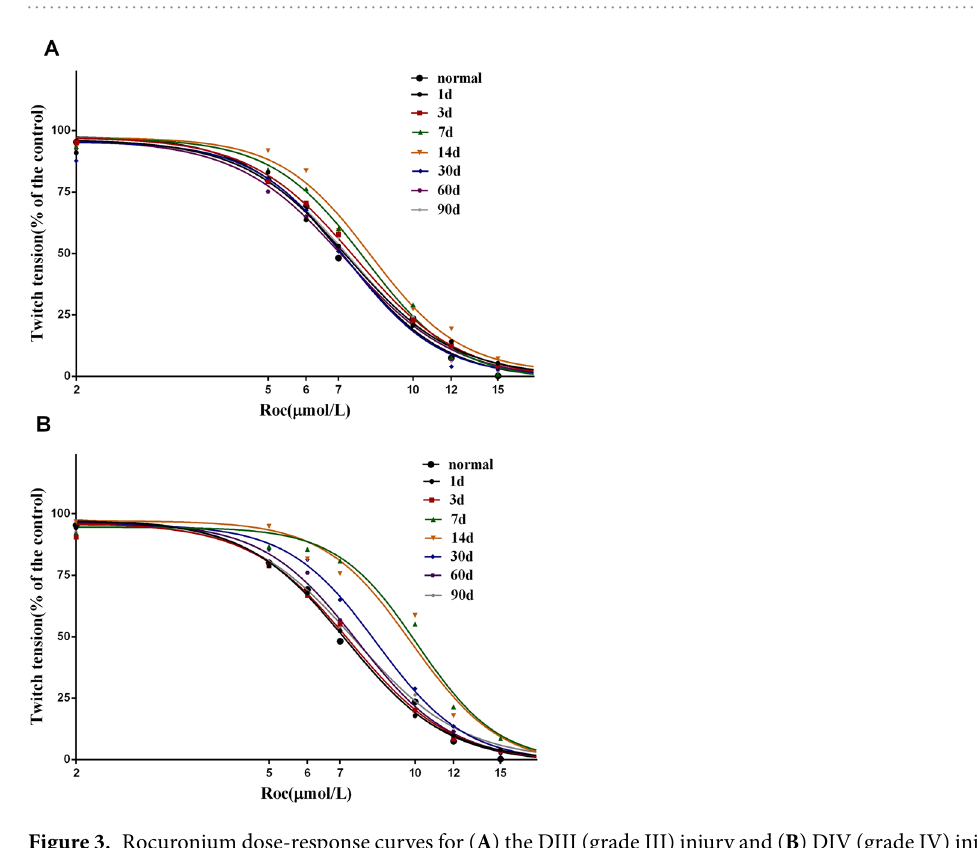
Figure 2. Rocuronium dose-response curves for the normal orbicularis oris and normal gastrocnemius. Values are means ± standard deviation.